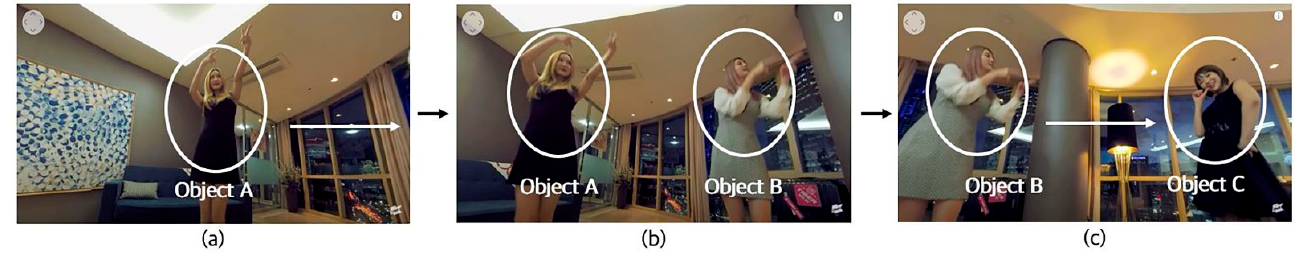
Figure 4. Directed Case 2 using “Hand gesture” (video No. 6). ( a ) The marked object A is beckoning in the direction of the arrow, ( b ) Object A and B are beckoning to the right, ( c ) The user can see object C, the main character, is dancing in the position intended by the